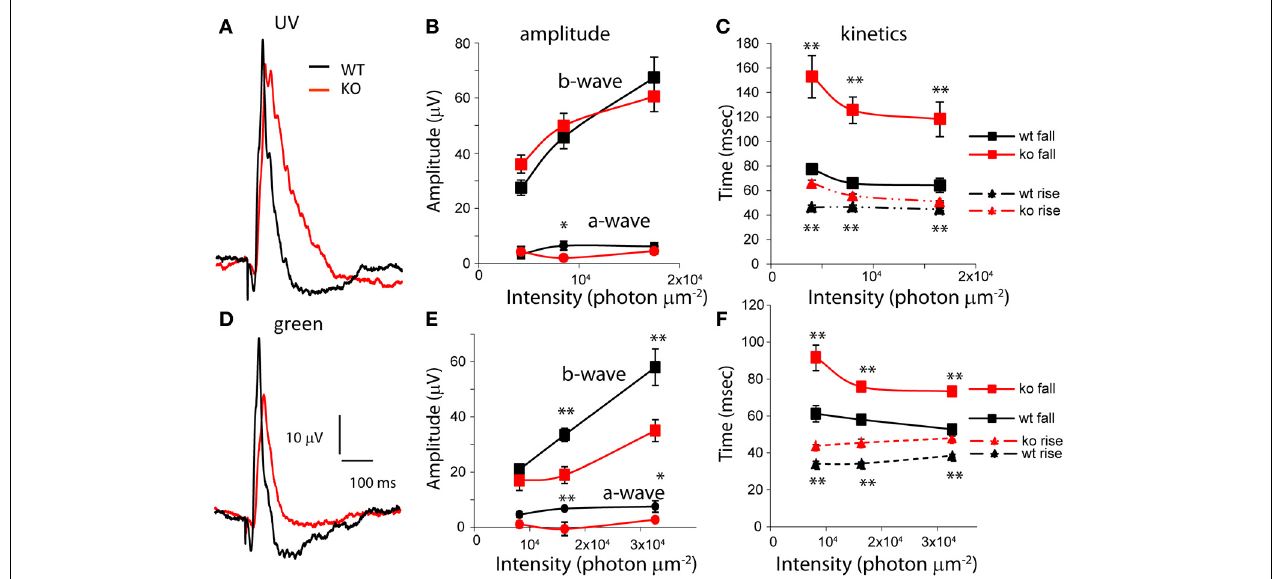
FIGURE 4 | PDE9A accelerates the kinetics of the photopic b-wave. (A) Average responses from WT and KO retinas to ultra-violet (UV) light of intensity 1 . 65 × 10 4 photons μ m − 2 (17 records were averaged for WT and 24 for KO). (B) Amplitudes of the a- and b-waves from WT ( n = 9–12 mice) and KO ( n = 12–13) retinas at increasing intensities of UV light. (C) The time taken by the b-wave to rise and fall to 66% of its amplitude at different intensities of stimulation. The time taken by the b-wave to rise